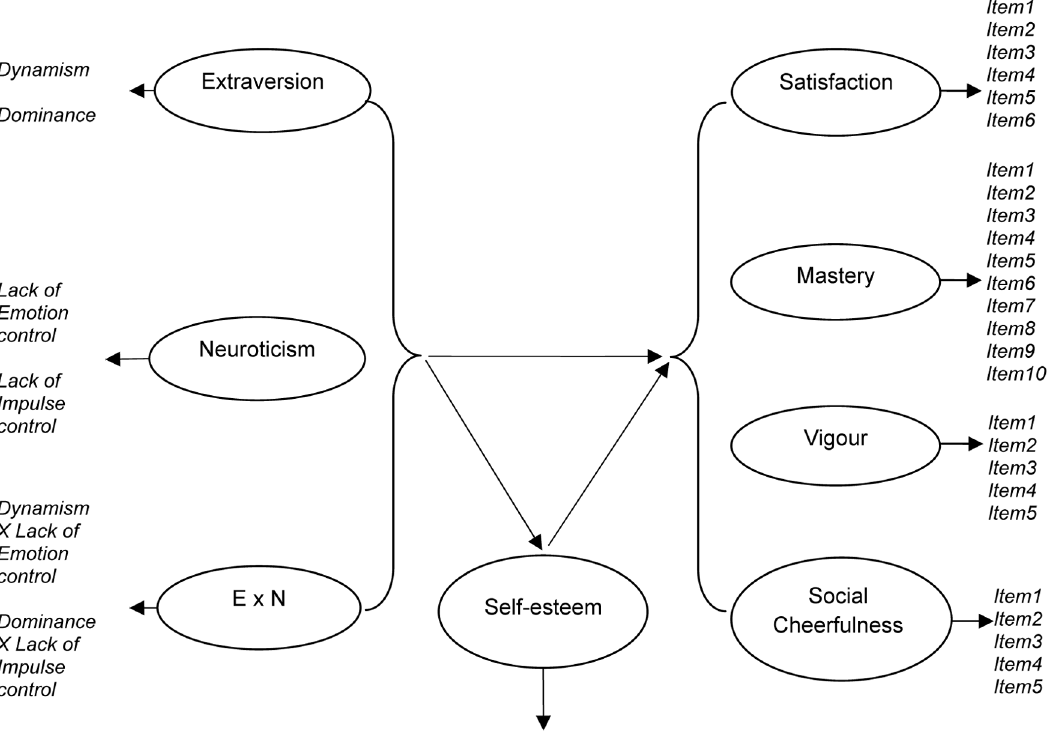
Figure 1. Conceptual path diagram. Note. The arrows indicate the causal direction of